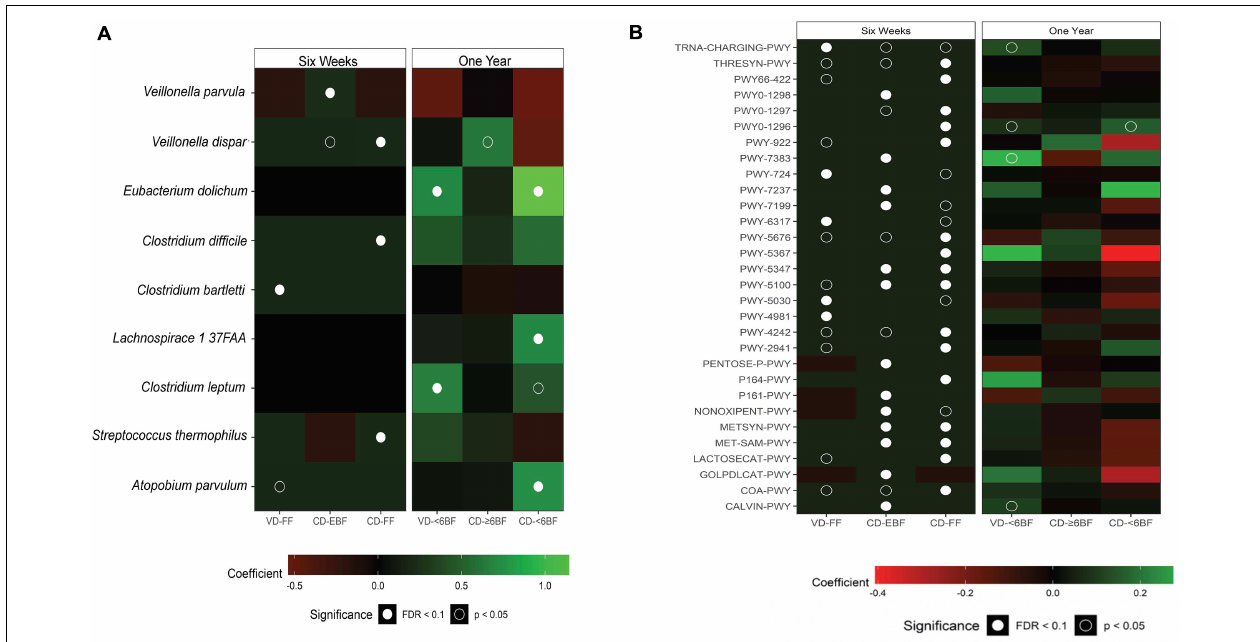
FIGURE 3 | Multivariable results from metagenomic sequencing (species level taxa and MetaCyc pathways). Heat maps showing the direction and size of model coefficients as determined by MaAsLin2 modeling (A) significant taxonomic differences and (B) significant functional pathways that differed relative to VD-EBF at 6 weeks and relative to VD- ≥ 6BF at 1 year. Figures include identified taxa with a FDR corrected q value < 0.25. VD-EBF, vaginally delivered and EBF; VD-FF, vaginally delivered and FF; CD-EBF, cesarean -delivered and EBF; CD-FF, cesarean -delivered who were FF; VD- ≥ 6BF, vaginally delivered who breast-fed for > 6 months; VD- < 6BF, vaginally delivered who never breast-fed or breast-fed for < 6 months; CD- ≥ 6BF, cesarean -delivered who breast-fed for ≥ 6 months; CD- ≥ 6BF, operatively delivered who never breast-fed or breast-fed for < 6 months; FDR, false discovery rate. TRNA-CHARGING-PWY, tRNA